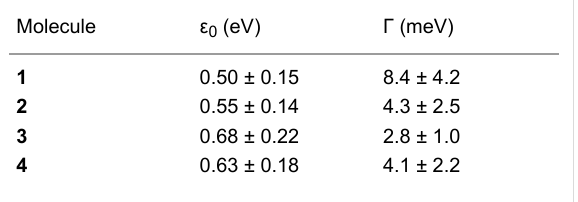
distribution corresponding in a log-normal both to the median and to the 50th percentile. Table 2 reports the results for the average injection barrier and electronic coupling, the confi-